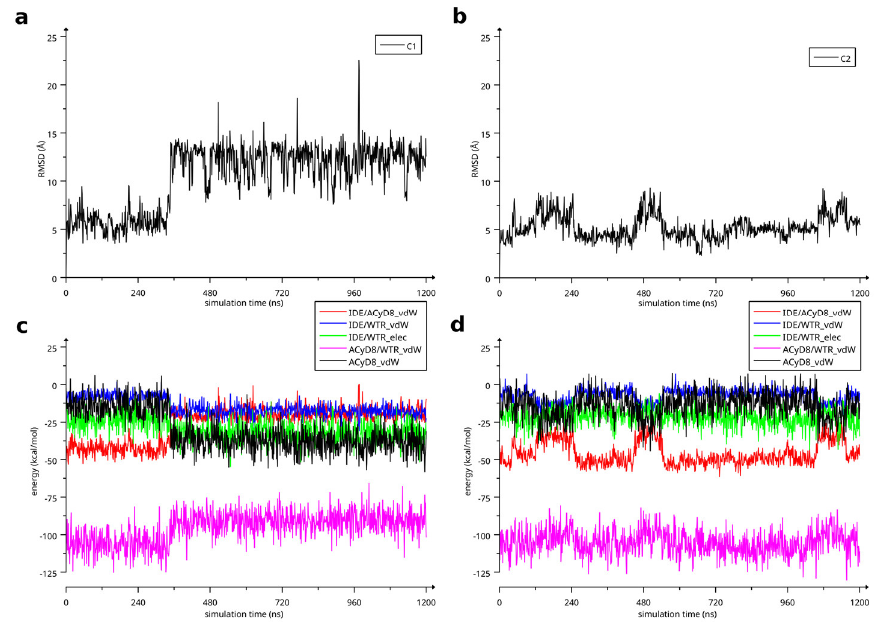
Figure 9. ( a ) RMSD of IDE atoms in complex1 as a function of MD simulation time; ( b ) RMSD of IDE atoms in complex2 as a function of MD simulation time. ( c ) Energetics of simulated complex1 as a function of simulation time. ( d ) Energetics of simulated complex2 as a function of simulation time.